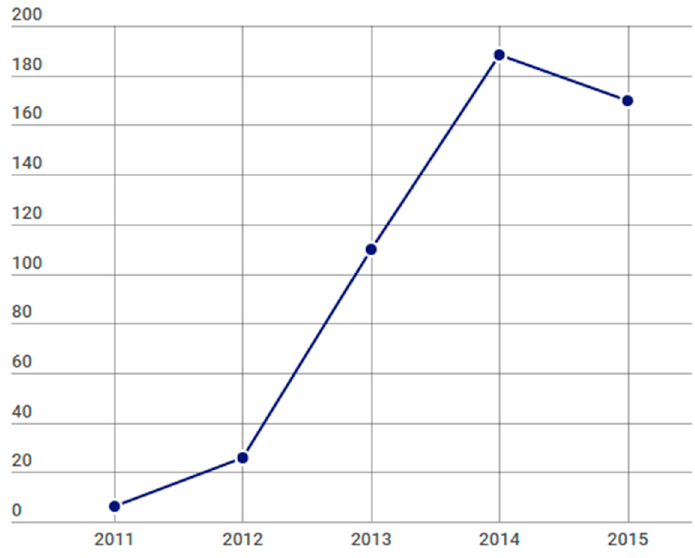
Figure 8. Quantity of papers per year.